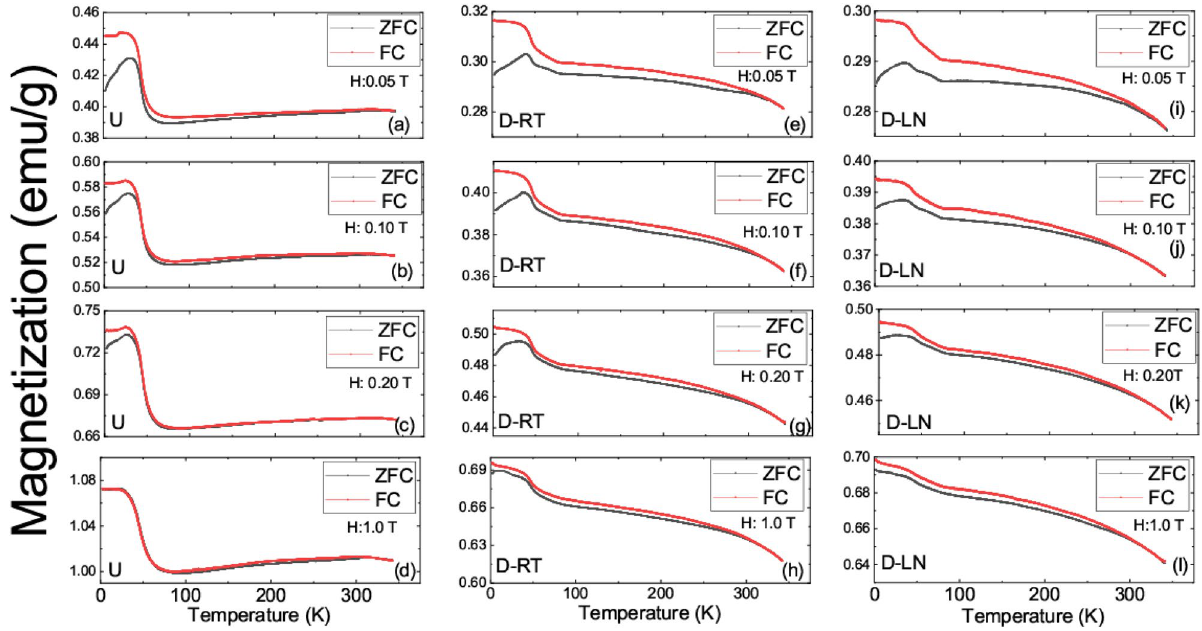
Figure 6. ( a – l ) Temperature dependence of the zero field cooled (ZFC) and field cooled magnetizations (FC) at indicated fields for undeformed and deformed